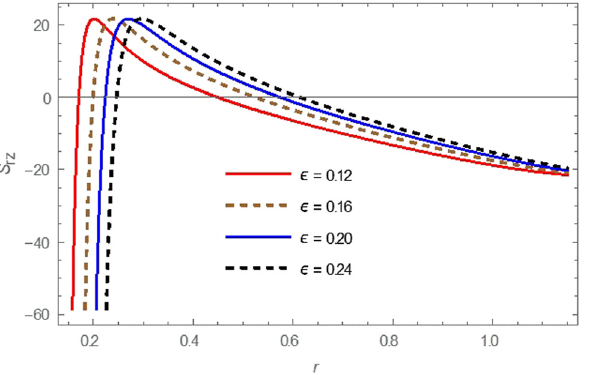
Figure 10: E ff ect of di ff erent values of Q 1 on stress with